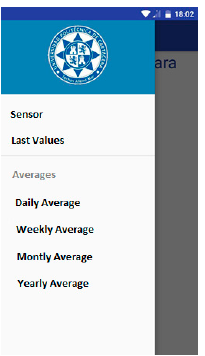
Figure 15. App statistical options.